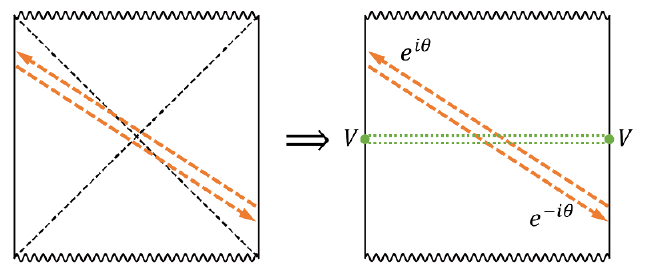
Figure 3 . Left: in a wormhole described by (1.1), due to entanglement between the two bound- aries, there are virtual particles which can propagate between them. The non-traversability can be understood as coming from perfect destructive interference between the process of a virtual particle traveling from R to L , and the mirror process of traveling from L to R . Right: turning on inter- action V subtly changes the entanglement structure and gives a phase for each propagation. Now the destructive interference is no longer perfect, resulting propagations of \real" particles between the boundaries. Note that the interference is not a process between \future" and \past" as the related two boundaries are actually spacelike separated. It is possible to boost the frame such that it occurs on one spatial